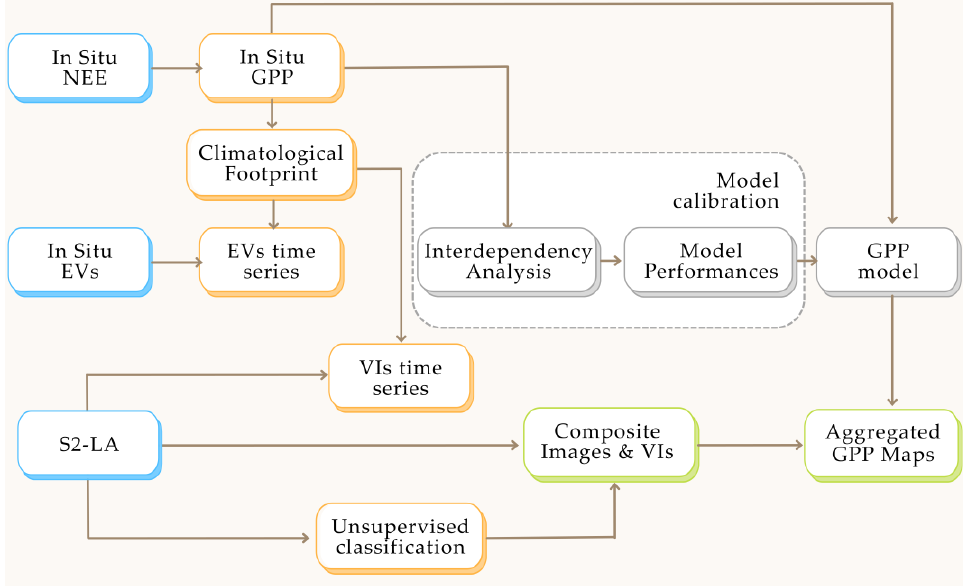
Figure 3. Schematization of methodology with details of data requirements (blue), data pre-processing (yellow), modeling processing (gray), and post-process and workflow outputs (green).